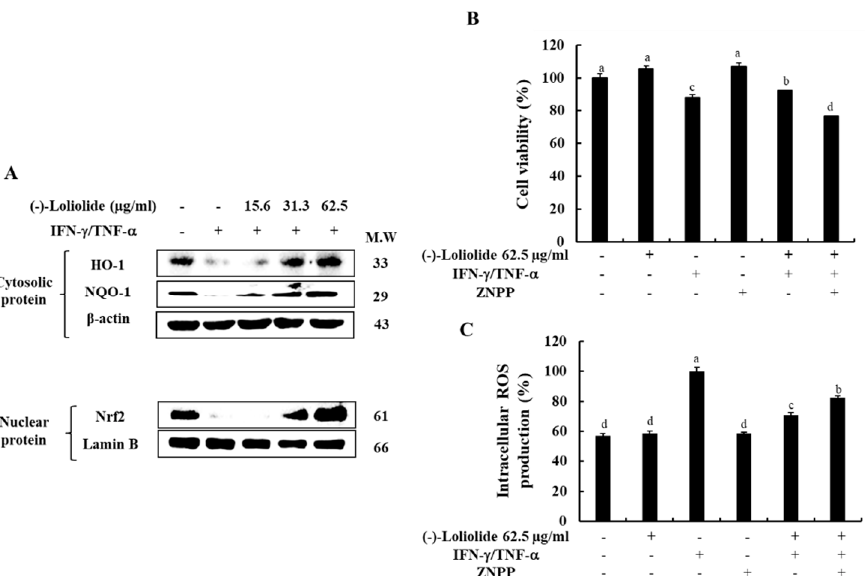
Figure 5. Effect of (–)-loliolide on the activation of the Nrf2/HO-1/NQO-1 signaling pathway ( A ) and influence of HO-1 inhibition on cell viability ( B ) and intracellular ROS production ( C ) in IFN- γ /TNF- α -stimulated HaCaT keratinocytes. The results represent data from three independent experiments (n = 3), and the values are indicated as the mean ± SE. Error bars with different letters are significantly different ( p < 0.05).